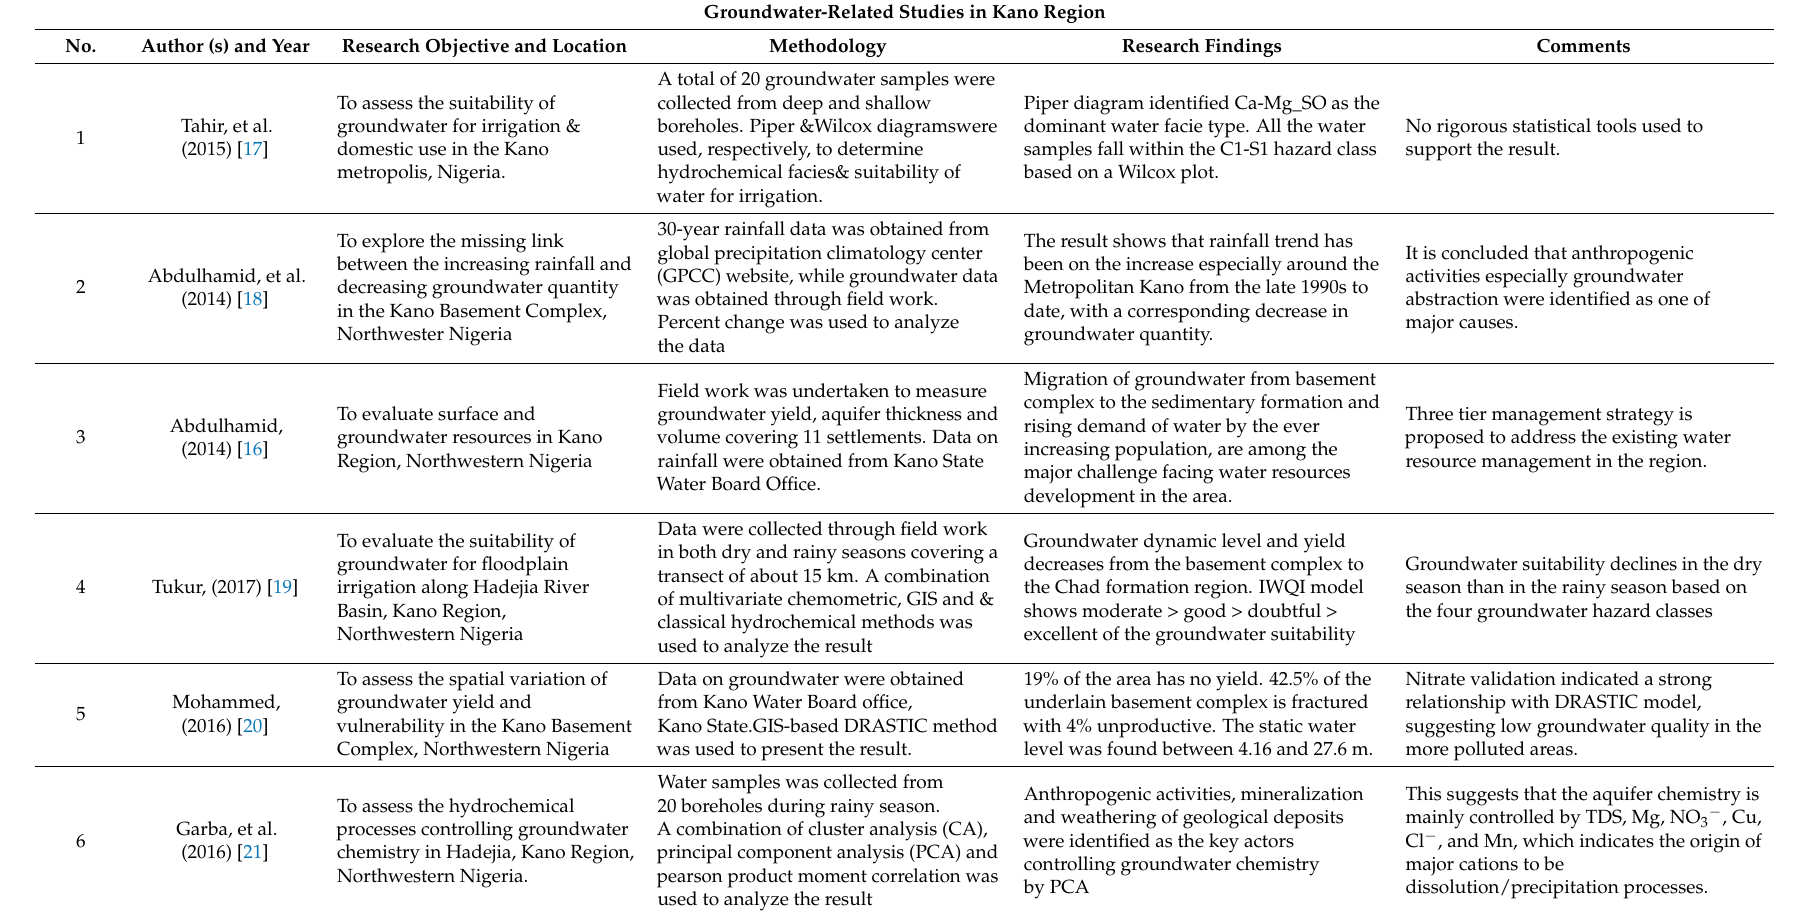
Table 1. Summary of Reviewed Groundwater-related Studies in Kano